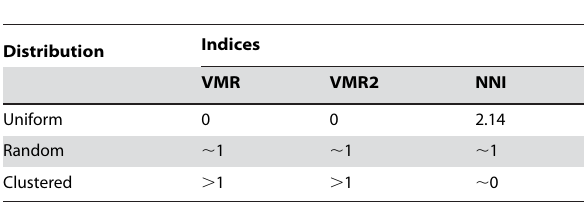
Table 1. Interpretation values for cluster indices.